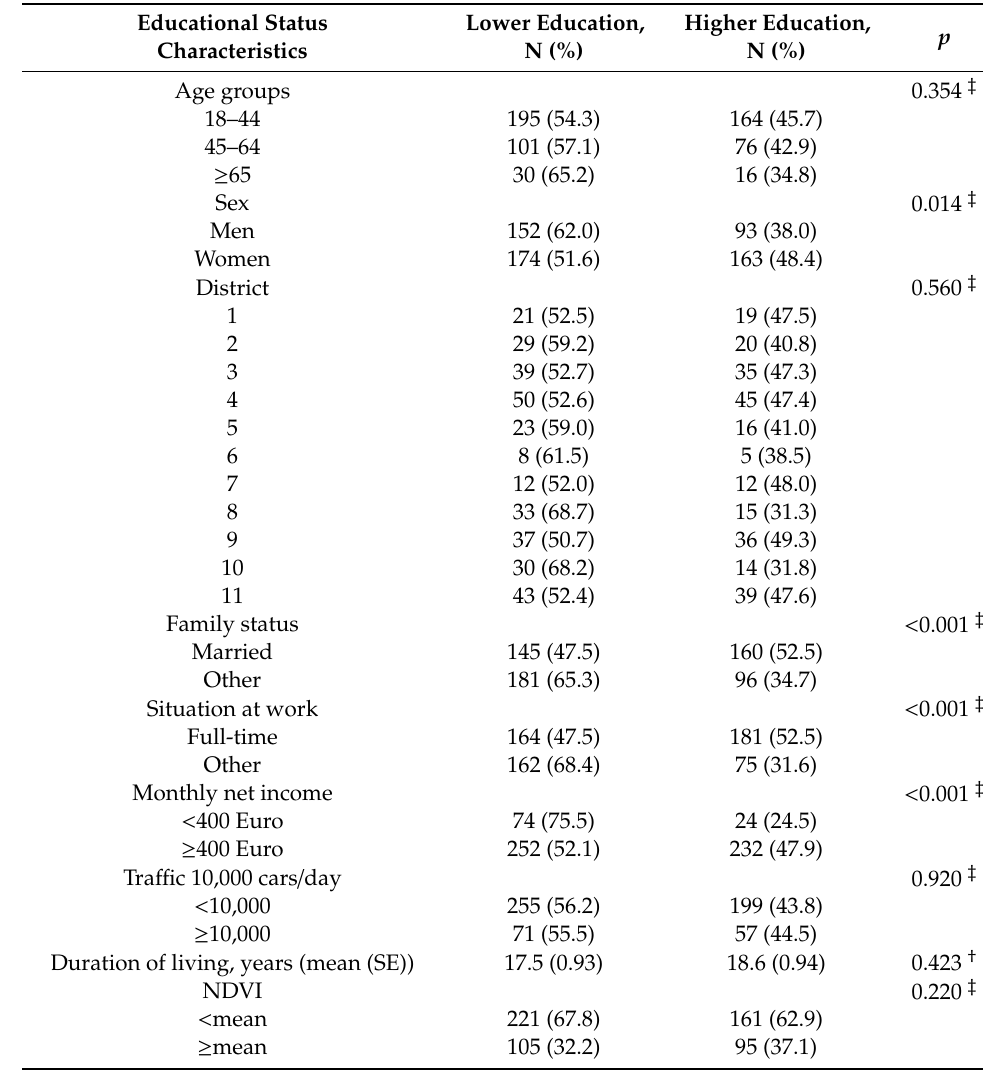
Table 1. Characteristics of the participants by education